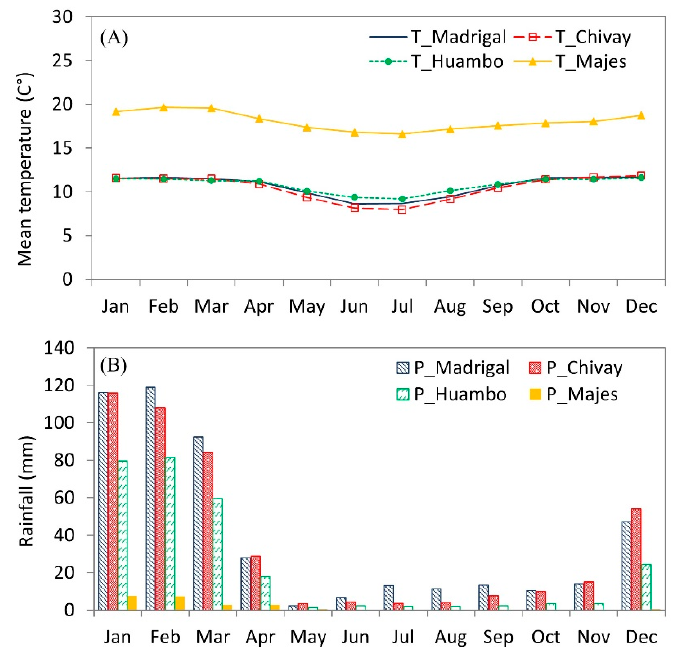
Figure 2. Monthly average temperature ( A ) and rainfall ( B ) in the study area at four climate loca- tions.